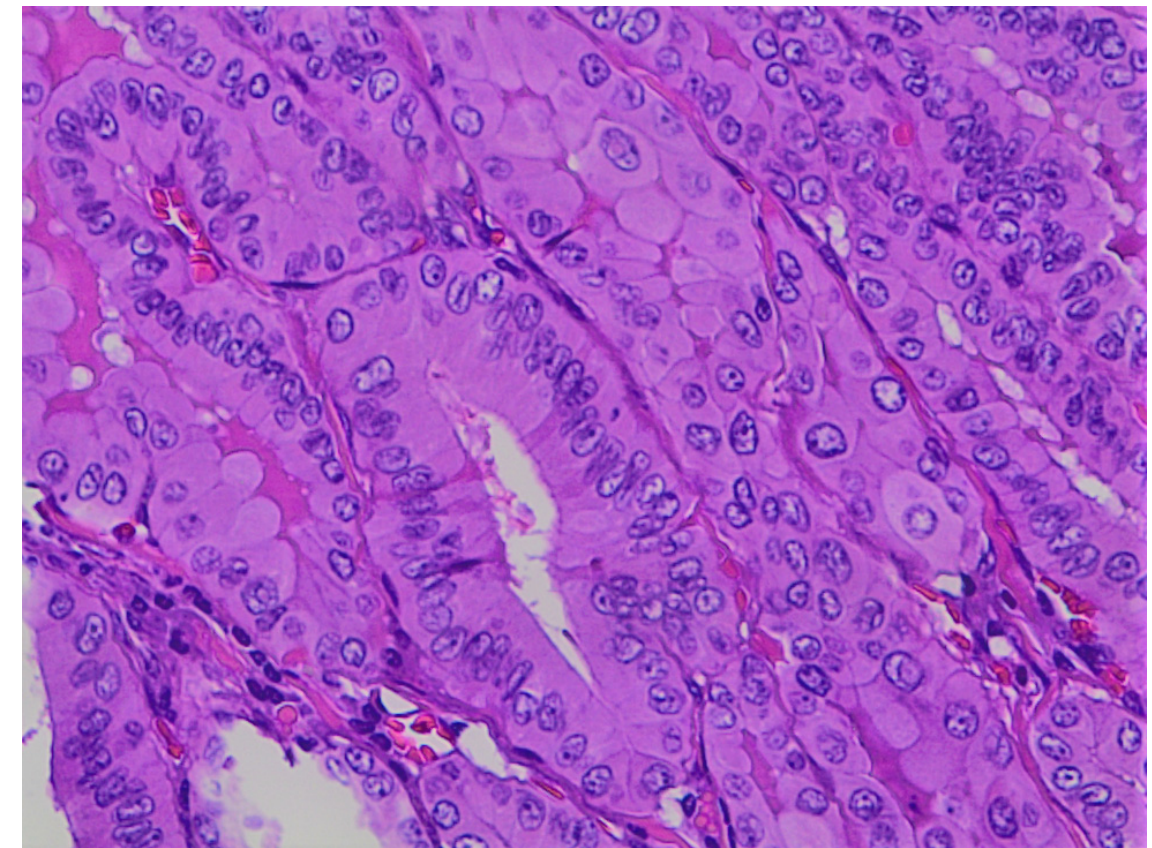
Figure 5. Details from a case of locally advanced thyroid carcinoma with tall cell variant of PTC component (200×, H&E).